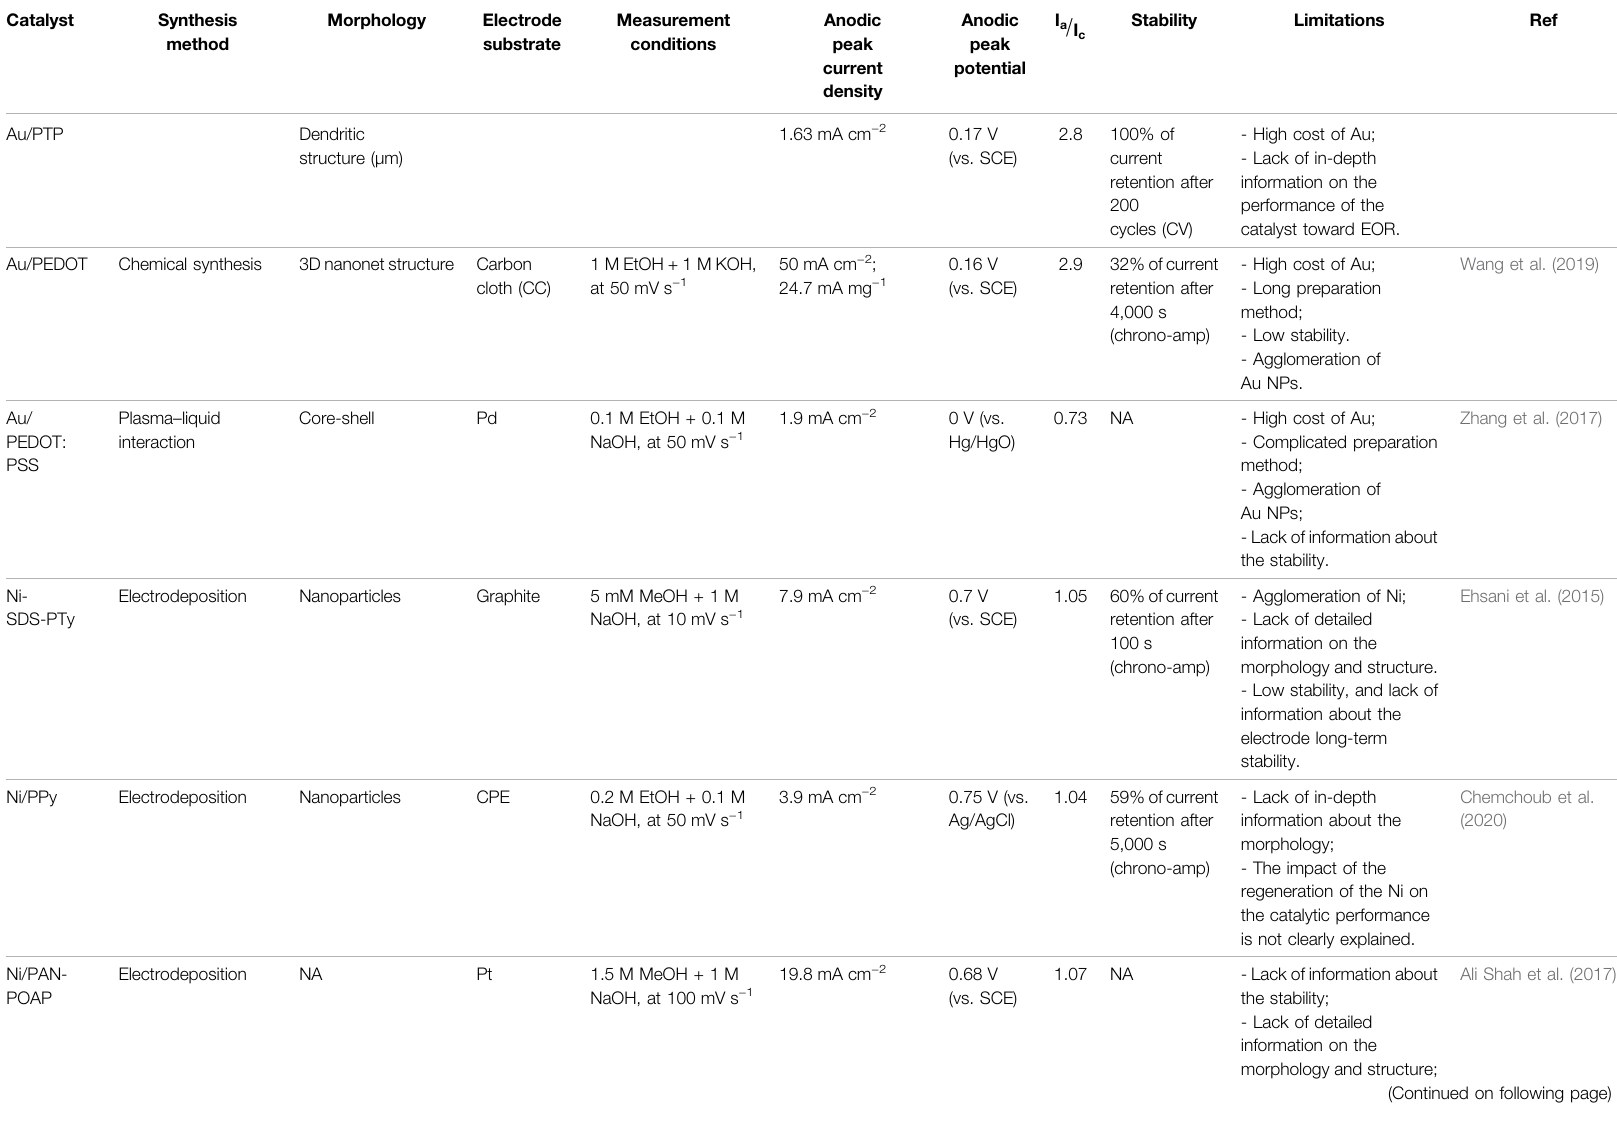
TABLE 2 | ( Continued ) Electrochemical properties and electrocatalytic performances of monometallic-based conducting polymers catalyst applied for alcohol